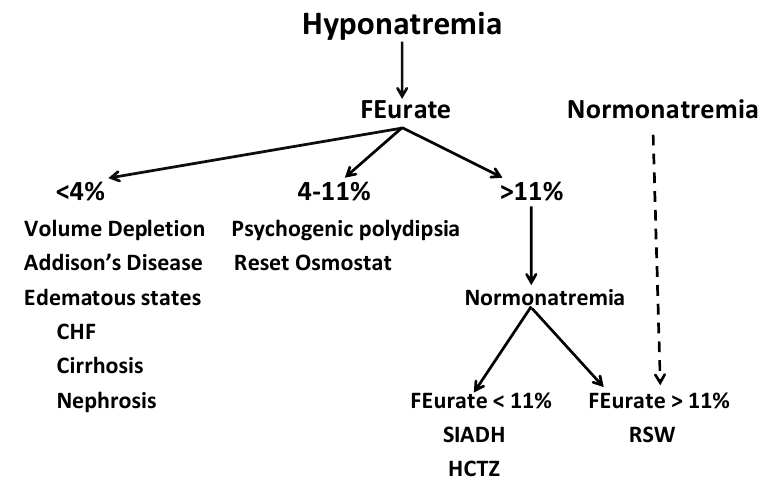
Figure 3. Algorithm for determining cause of hyponatremia, using